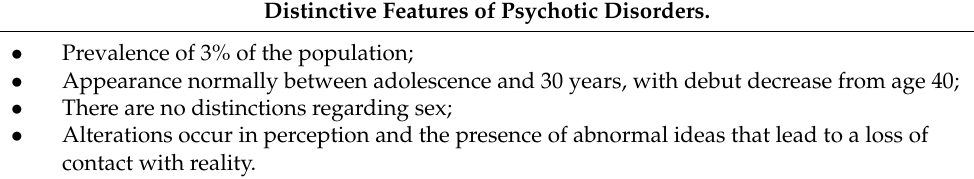
Table 1. Characteristics of psychotic disorders. Distinctive Features of Psychotic Disorders.